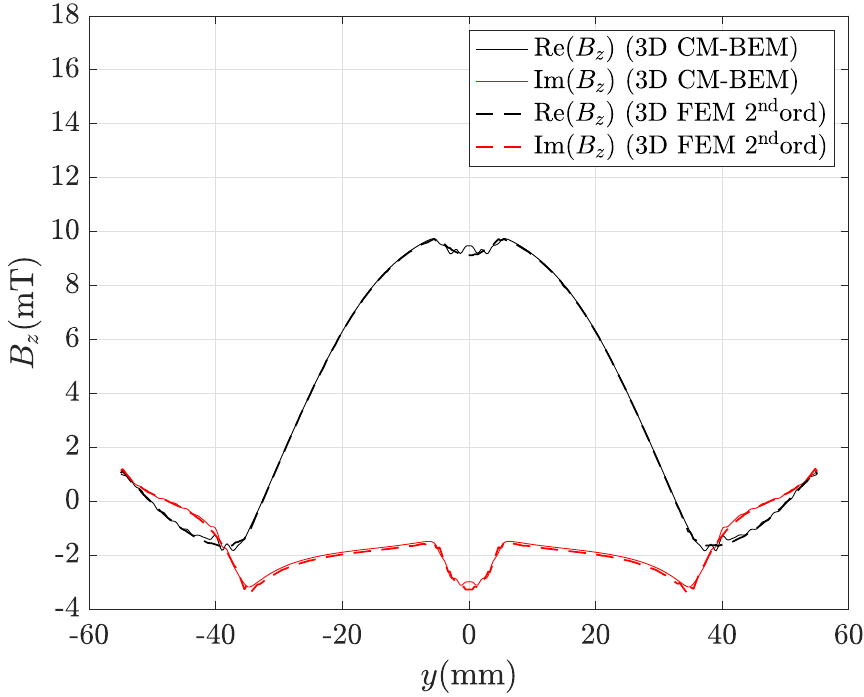
Figure 12. Real and imaginary parts of the magnetic flux density radial component B z along line AB depicted in Figure 8 computed by the hybrid method (R-SVD matrix compression) with the coarsest mesh (69,492 tets): CM-BEM is the straight line, second ord. 3D FEM (reference) is the dashed line.